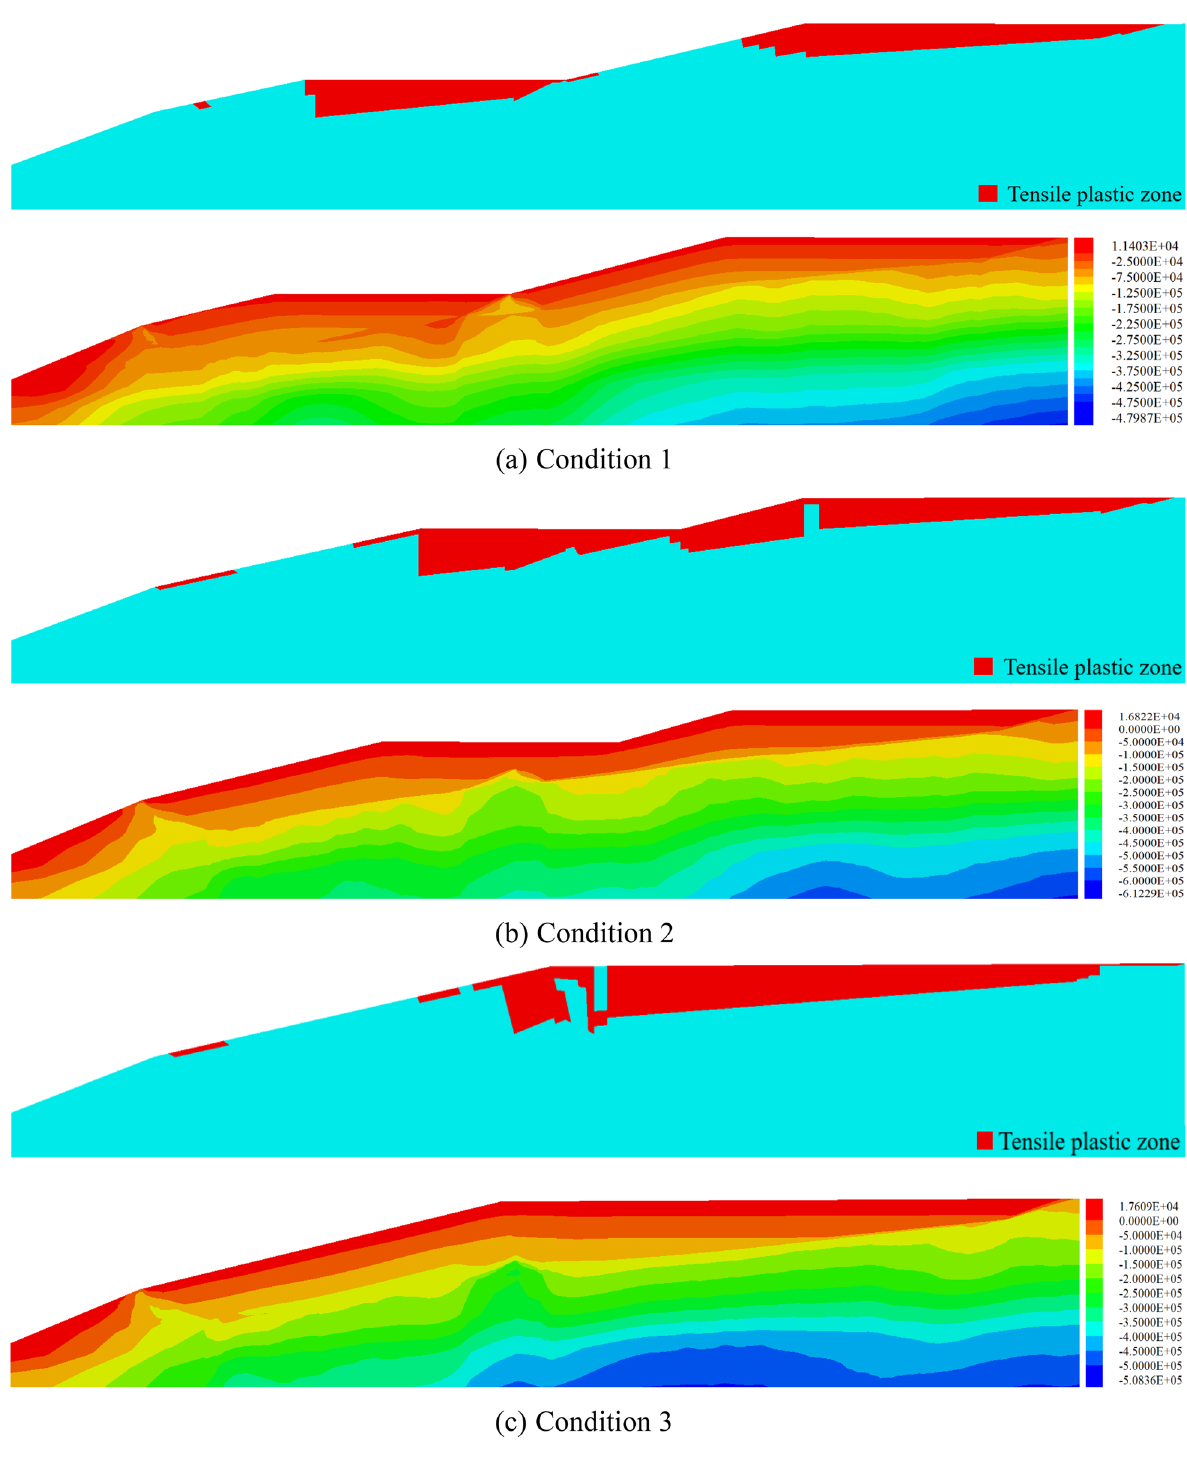
Figure 9. Distribution of tension plastic zones and the minimum principal stress in new and original reservoir